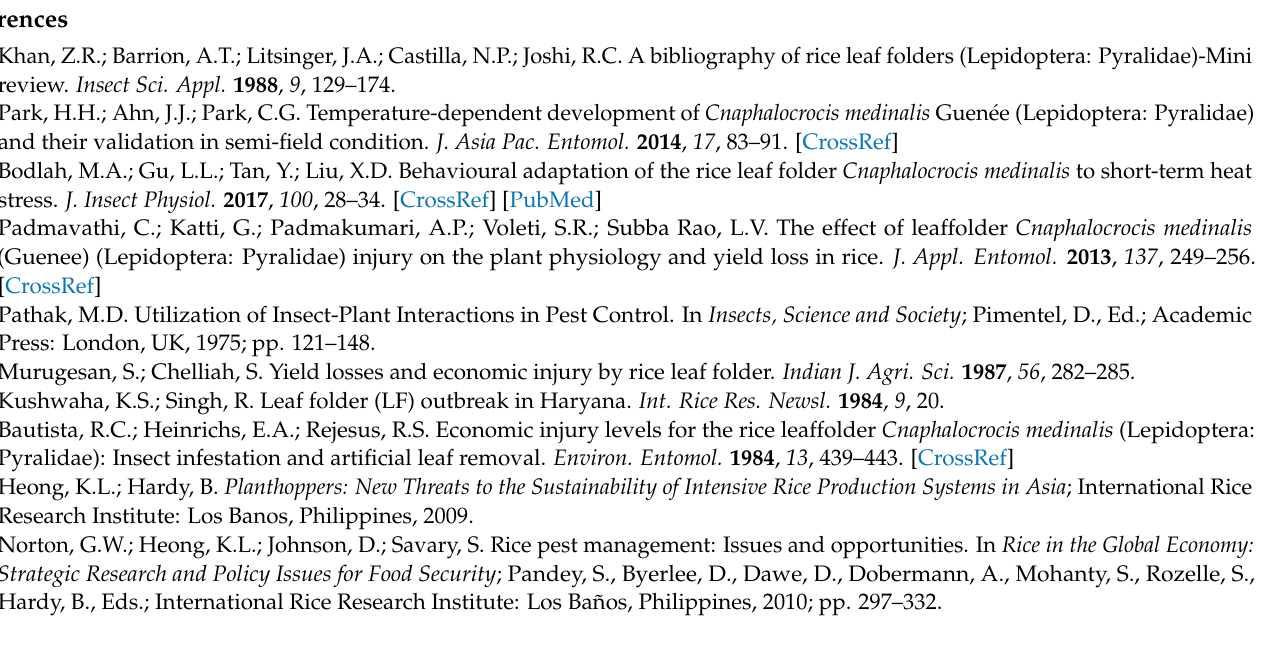
Figure S2: Confusion Matrix result of DNN model, Figure S3: Prediction of spectral information from unknown rice sample, Figure S4: Entoscan Plant imaging system, Figure S5: Approximate time required for each step of the prediction of unknown samples, Table S1: Results of the first six bands of band selection using different criteria, Table S2: The accuracy of DNN classification evaluated by confusion